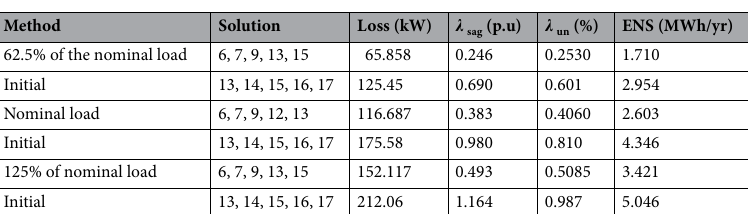
Table 7. Effect of changing the demand for the multiobjective problem of the unbalanced 13-bus network via